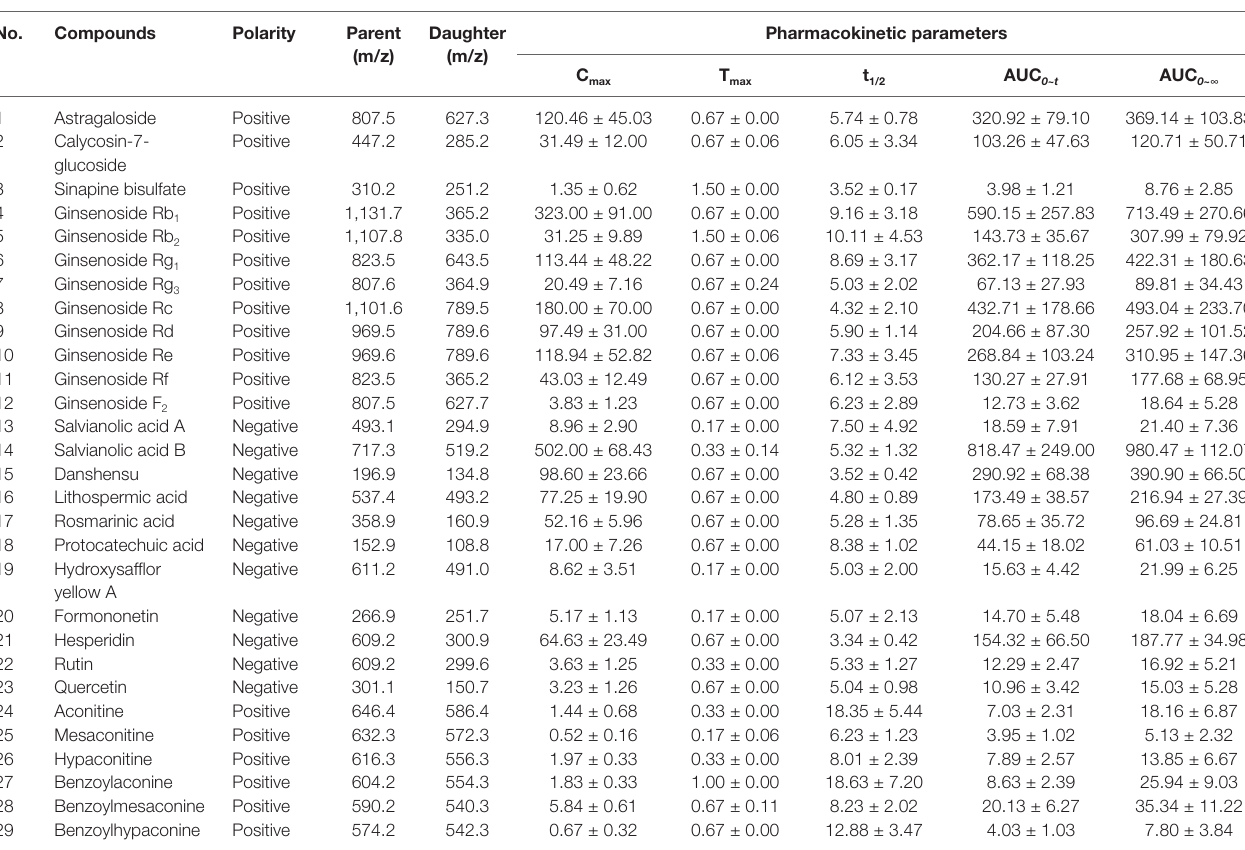
TABLE 1 | Pharmacokinetic properties of 29 components in QLQX determined by HPLC-MS/MS. No.